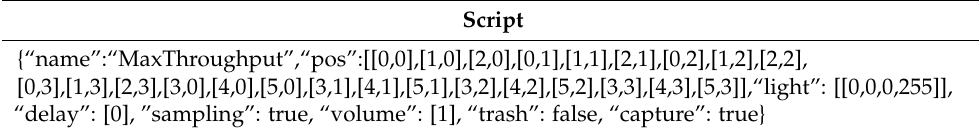
Table 4. Script used to test the throughput of the robot.